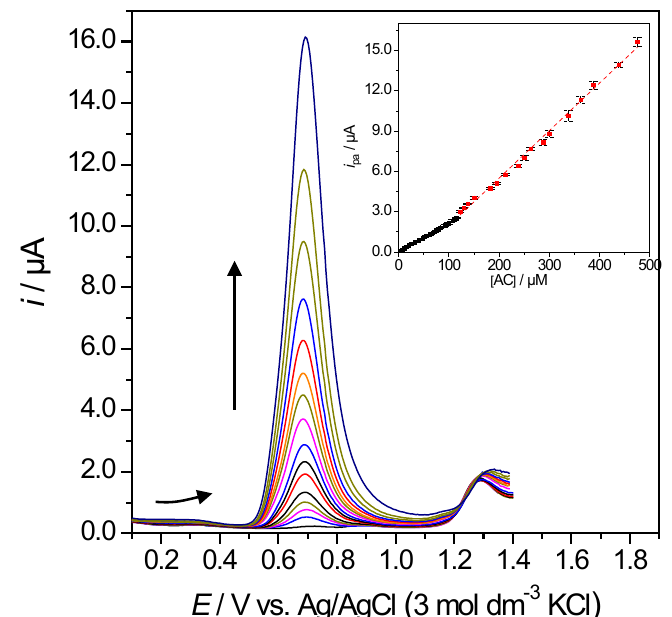
Figure 6. Square-wave voltammetric response at a PMo 11 V@N-FLG/GCE in pH 2.5 buffer solution containing 1.0 × 10 − 4 mol dm − 3 TP and different concentrations of AC from 1.2 × 10 − 6 to 4.8 × 10 − 4 mol dm − 3 . Inset: plots of the anodic peak current as a function of the AC concentration.